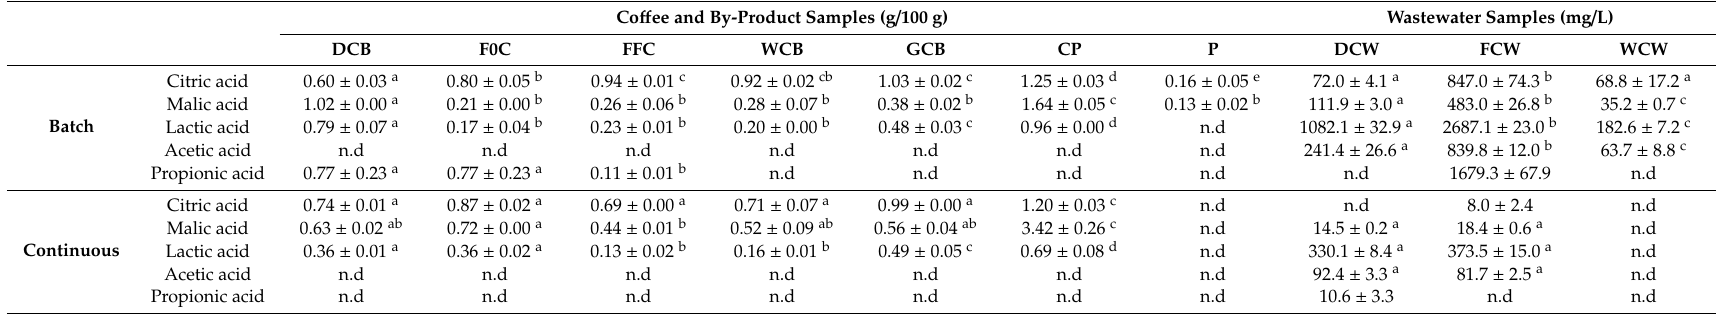
Table 1. Composition of organic acids in co ff ee beans, co ff ee by-products and wastewater during the batch and continuous processing. Co ff ee and By-Product Samples (g / 100 g) Wastewater Samples (mg /